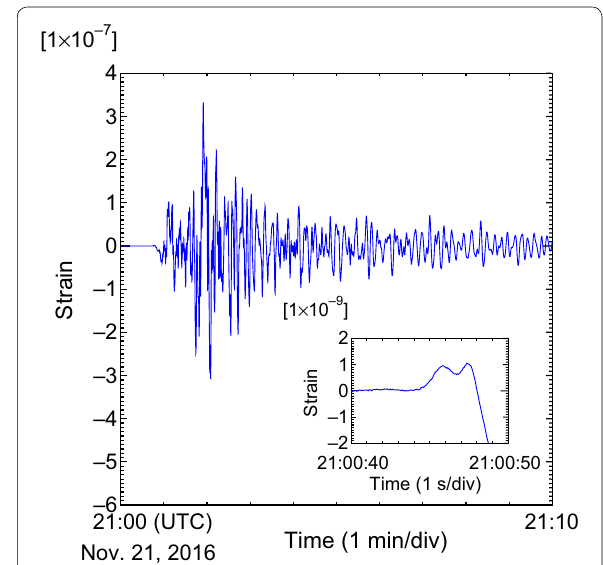
Fig. 6 Seismic waves associated with the Fukushima earthquake (Mw 6.9) that occurred at 20:59:49 (UTC) on November 21, 2016 (expansion positive); the inset is a magnified view around the initial motion. The peak-to-peak strain amplitude was 6.4 fringe signals were normally converted to strain without saturation or discontinuity due to cycle